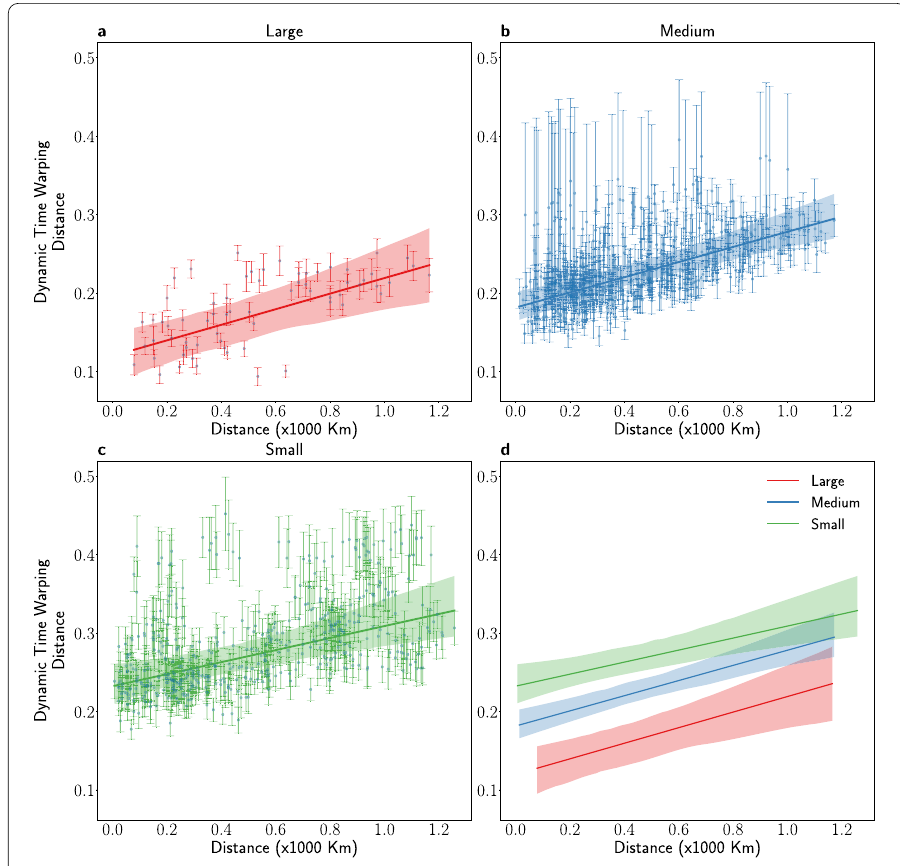
Figure 3 Bootstrap for weekdays. ( a ) shows the results of the bootstrap for couples of Large cities during the weekdays. The point and the bars represent the mean and the variance obtained for each couple through the jackknife sampling method. The shaded area represents the 95% confidence interval obtained using the bootstrap method described in Materialsandmethods and the line represents the bootstrapped Weighted Least-Square Regression (WLS) fit. ( b ) as ( a ) but for the Medium cities. ( c ) as ( a ) but for Small cities. ( d ) summarizes the estimates of the bootstrap regression previously obtained in figures ( a )–( c ). Note that 95% confidence intervals for all the classes mostly do not overlap. Detailed statistics are reported in Table 1